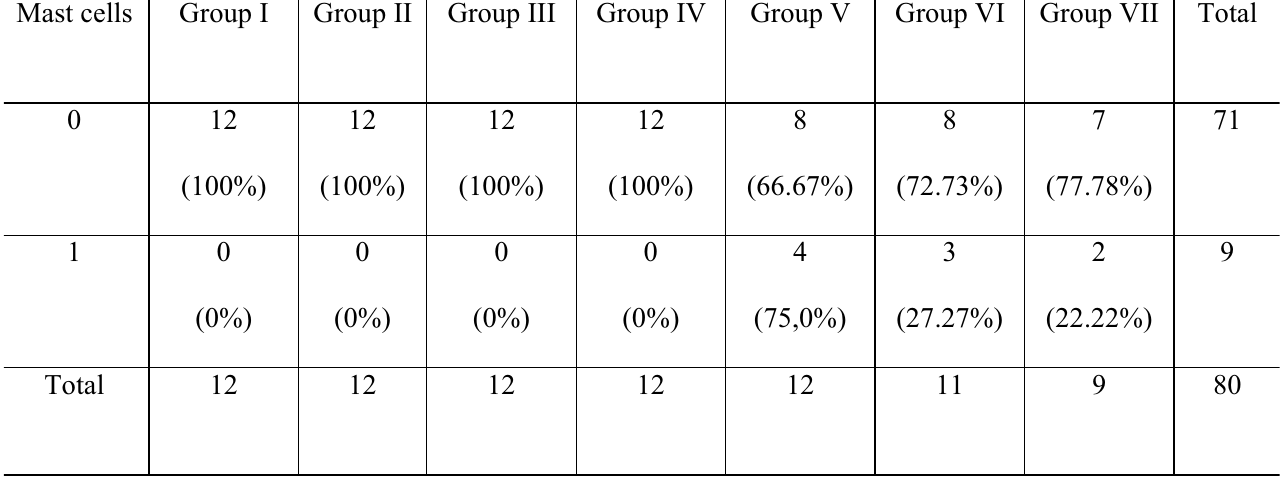
TABLE 2 – Comparative analysis of mast cells in the Groups (Fisher Test: